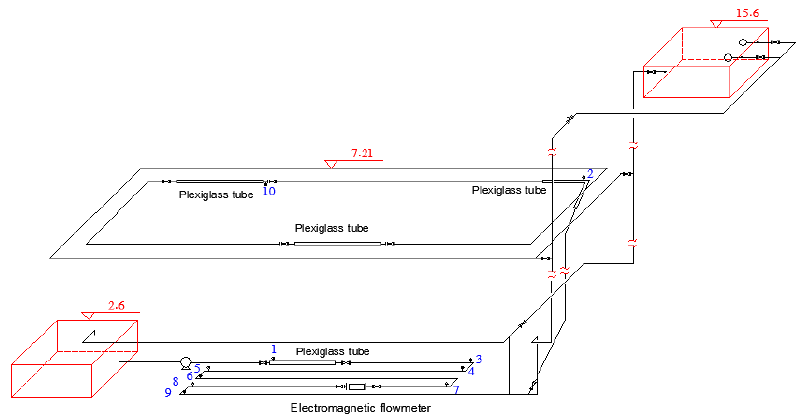
Figure 2. Schematic of the experimental pipeline system. Note: The blue numbers indicate the position of the pressure sensor.